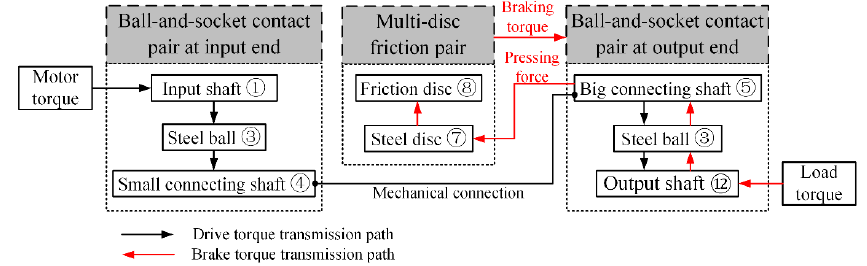
Figure 2. Rear left hatch door of through cabin and non ‐ return mechanism: ① Input shaft, ② Sup ‐ port bearing, ③ Steel ball, ④ Small connecting shaft, ⑤ Big connecting shaft, ⑥ Pressure plate, ⑦ Steel disc, ⑧ Friction disc, ⑨ Wave spring, ⑩ Housing, ⑪ Thrust bearing, ⑫ Output Shaft, ⑬ Main Reducer, ⑭ Motor, ⑮ Transmission shaft 1, ⑯ Planetary reducer, ⑰ Transmission shaft 2, ⑱ Rocker arm, ⑲ Link lever, ⑳ Door.